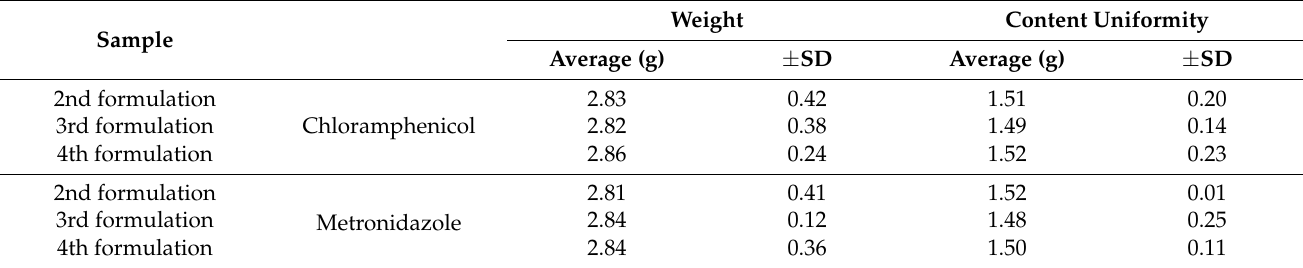
Table 4. The samples’ average weight (g) with standard deviation (SD) and the average content uniformity (g) results with SD in case of the three different formulations containing chloramphenicol and metronidazole.